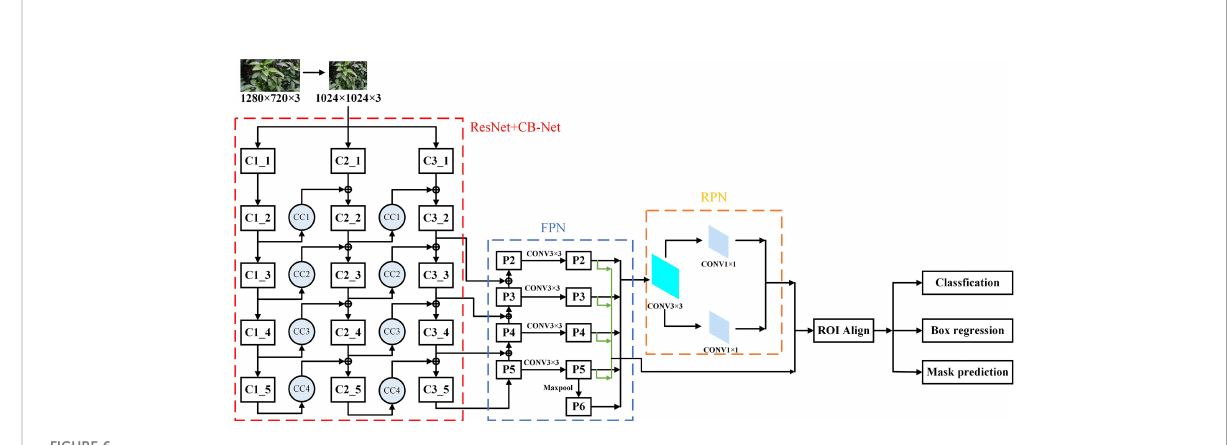
FIGURE 6 The structure of Mask-RCNN model integrating CB-Net